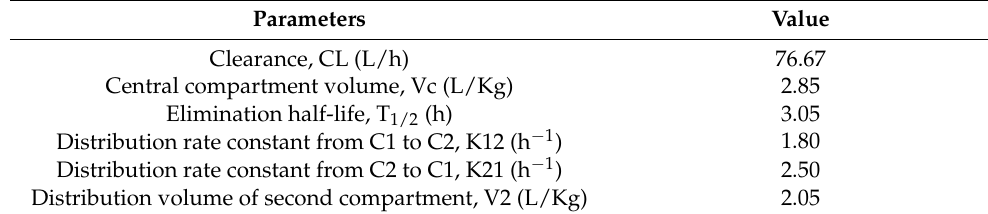
Table 10. Summary of the two-compartment data for metoprolol calculated using the PKPlus™ module in GastroPlus ® . Parameters